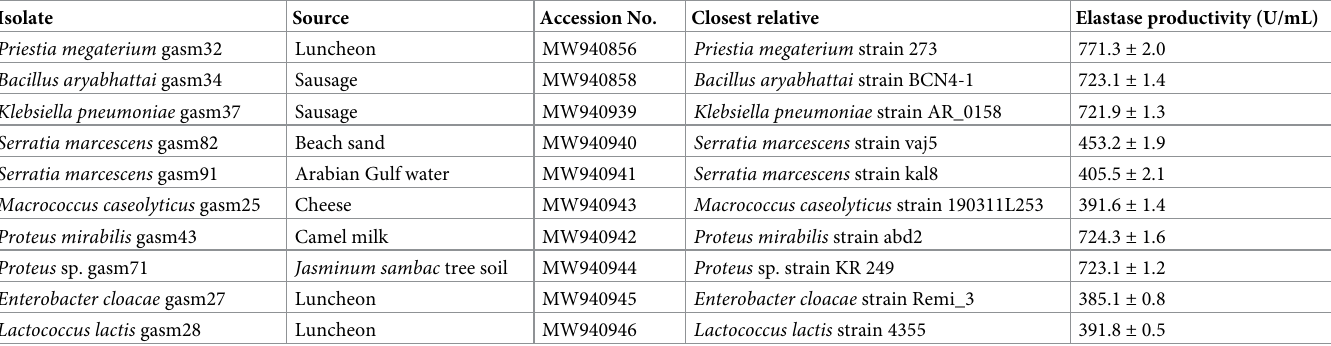
Table 1. The top ten elastase-positive bacterial isolates identified by 16S rRNA analysis.